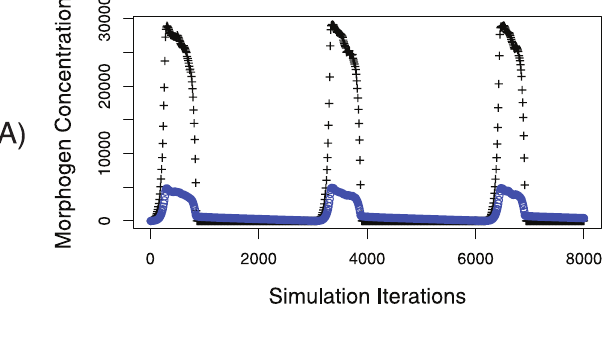
Table 3. Robustness of Average Peak Interval and